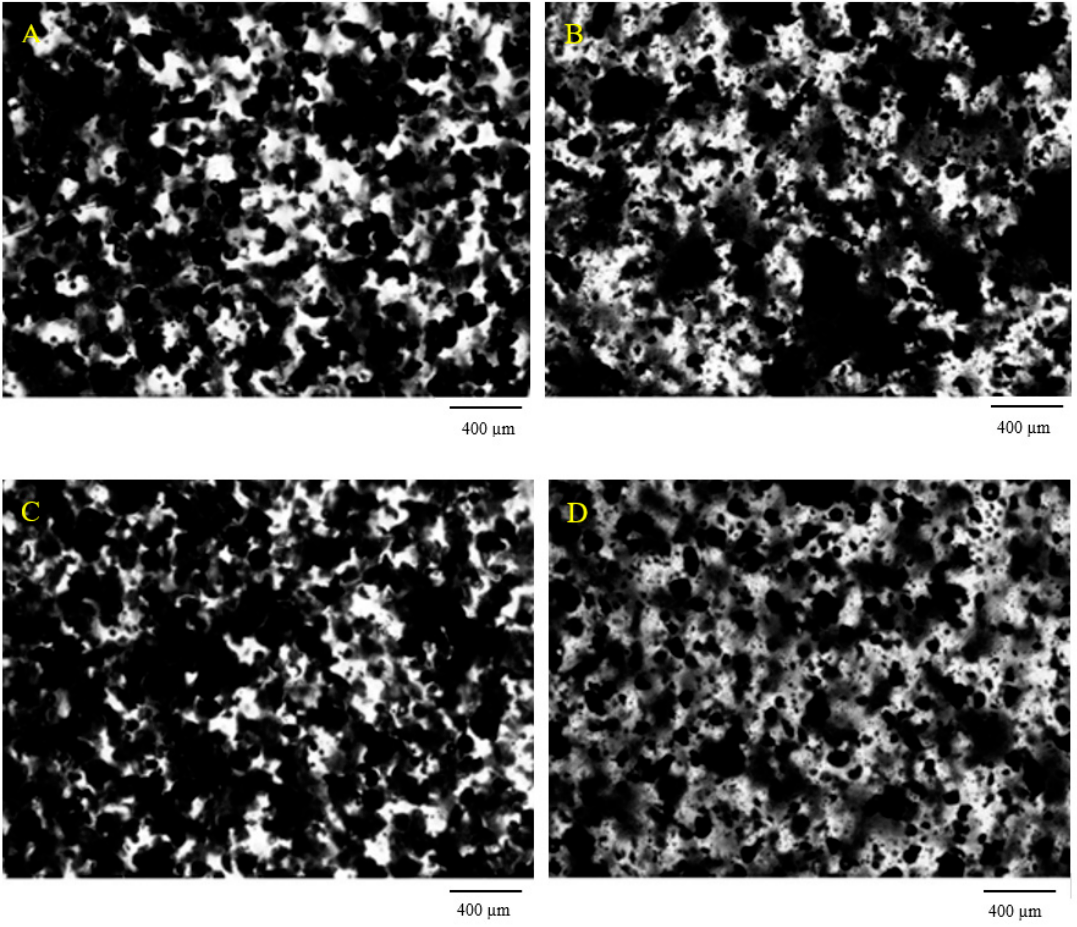
Figure 5. Photos of the synthesized biopolymers obtained using a Morphologi G3 optical microscope, magnification 2.5 × , ( A ) 0%P + 5%L, ( B ) 0%P + 5%L P , ( C ) 2%P + 5%L, ( D ) 2%P + 5%L P .